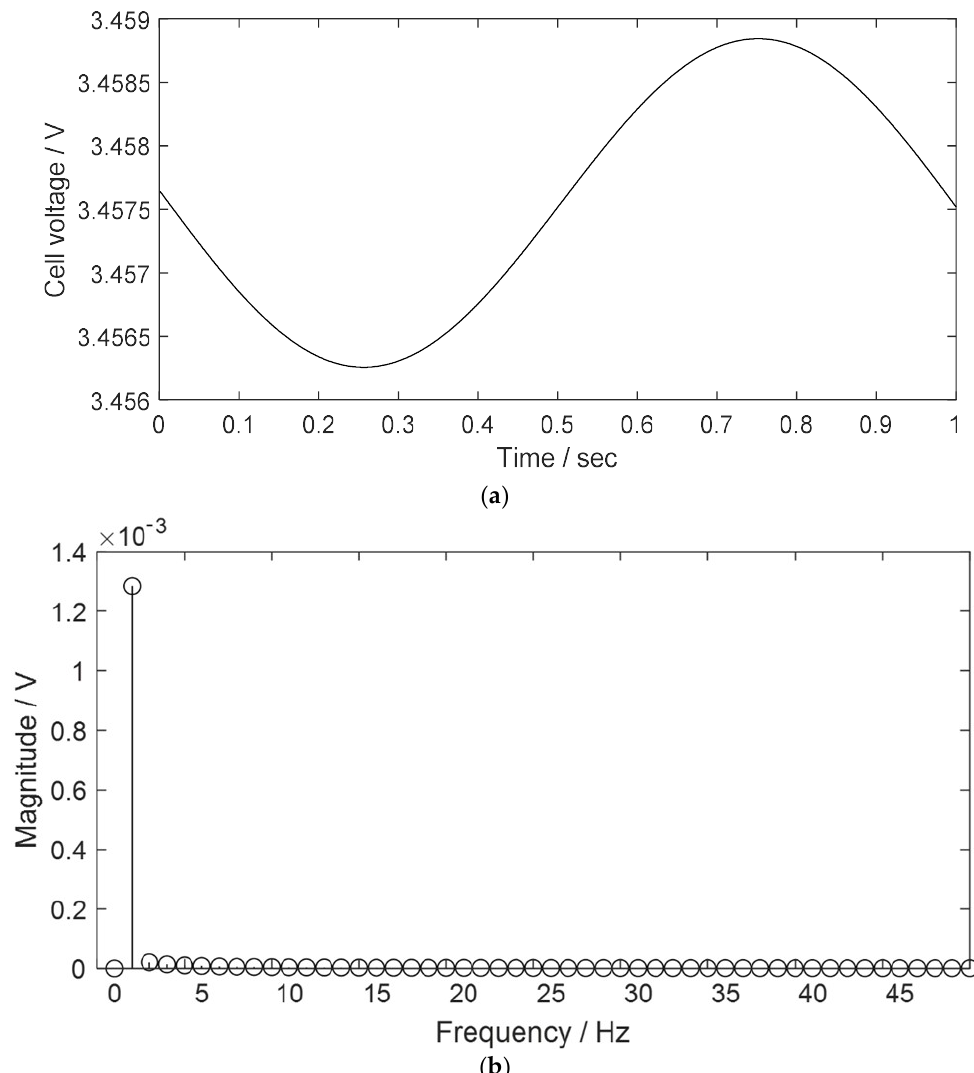
Figure 3. Voltage response simulated for 1 s at a cell SoC of 50% ( a ) in a time domain and ( b ) in a frequency domain.